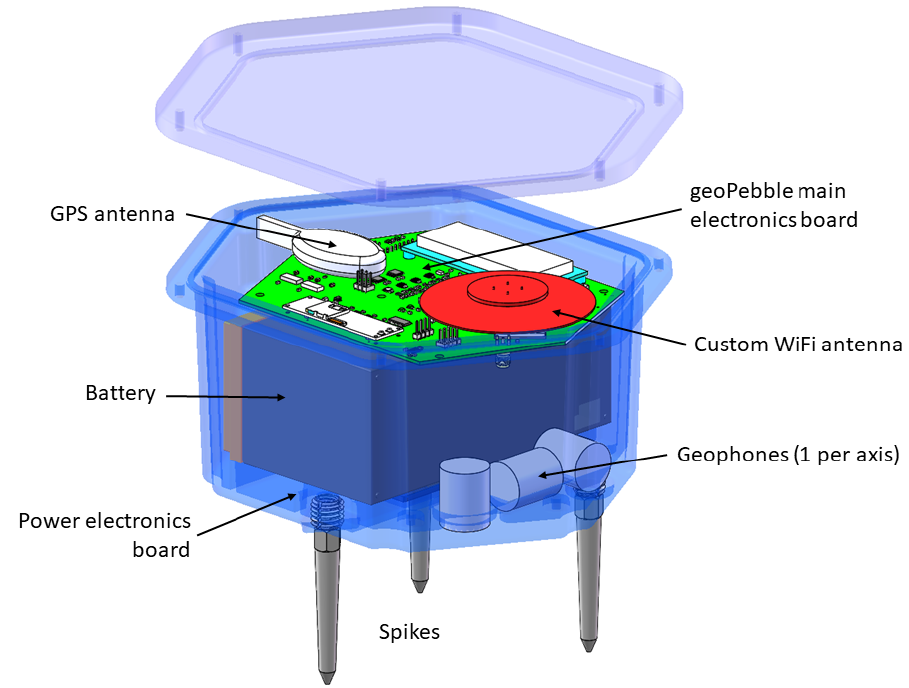
Figure 5. Housing for geoPebble node with installed components. Note that the WiFi antenna of Figure 4 and the GPS antenna both look vertically through lid, which is optically and electri- cally